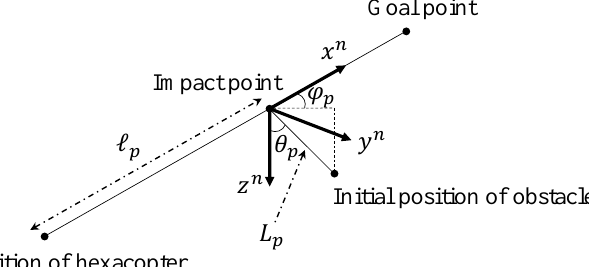
Figure 12. Generating obstacle properties for Monte Carlo simulation (Simulation III).